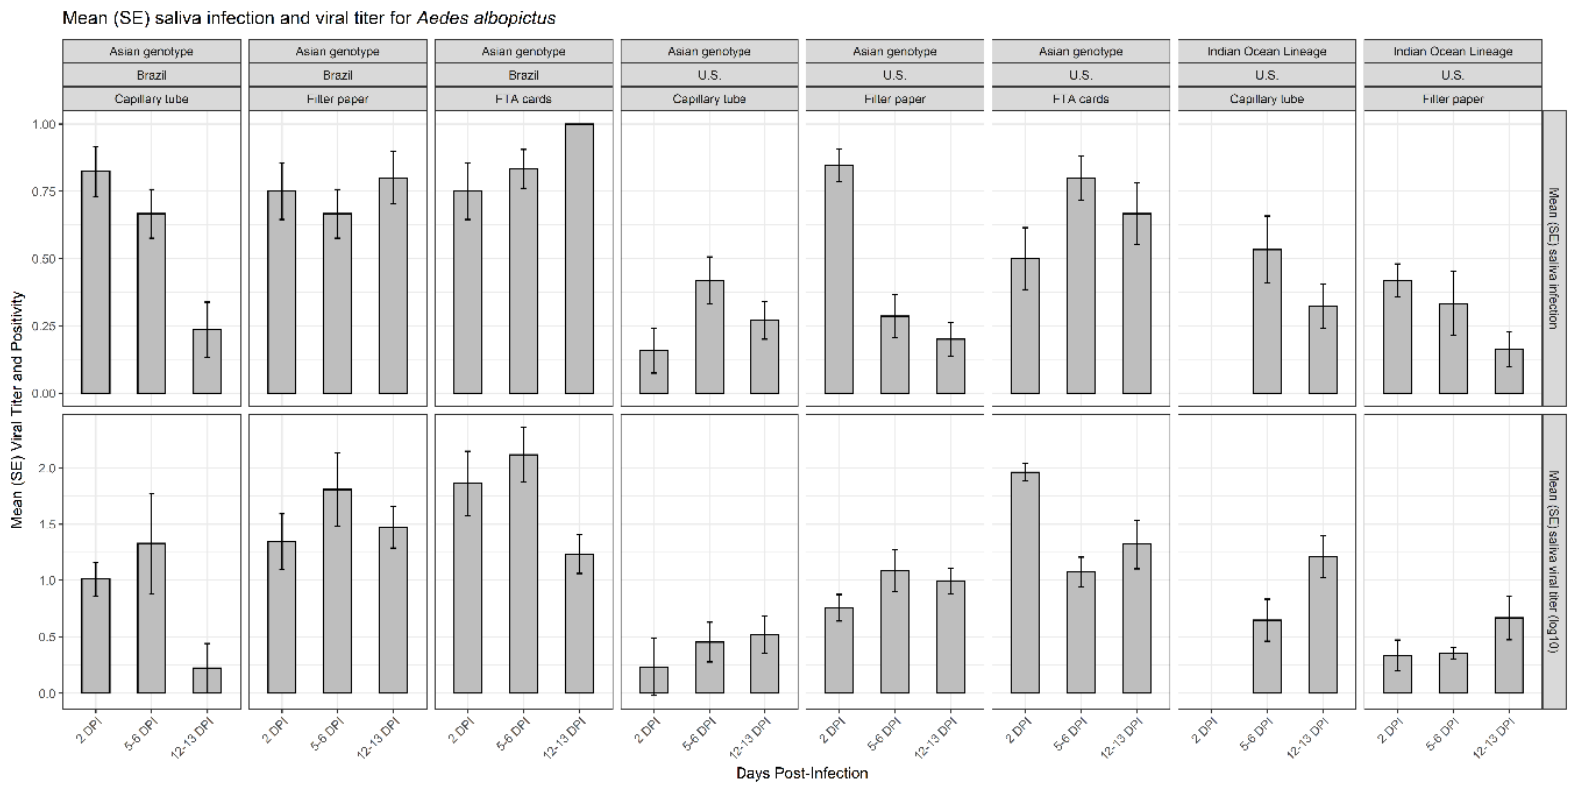
Figure 2. Mean (SE) proportion of saliva infection and viral titer (log 10 pfue/mL) of Ae. albopictus from Brazilian and US populations, measured by three different methods (capillary tube, filter paper, and FTA card) at different days post-infection (DPI; 1 = 2 DPI, 2 = 5 to 6 DPI, 3 = 12 to 13 DPI), for two CHIKV genotypes (Asian and IOL).